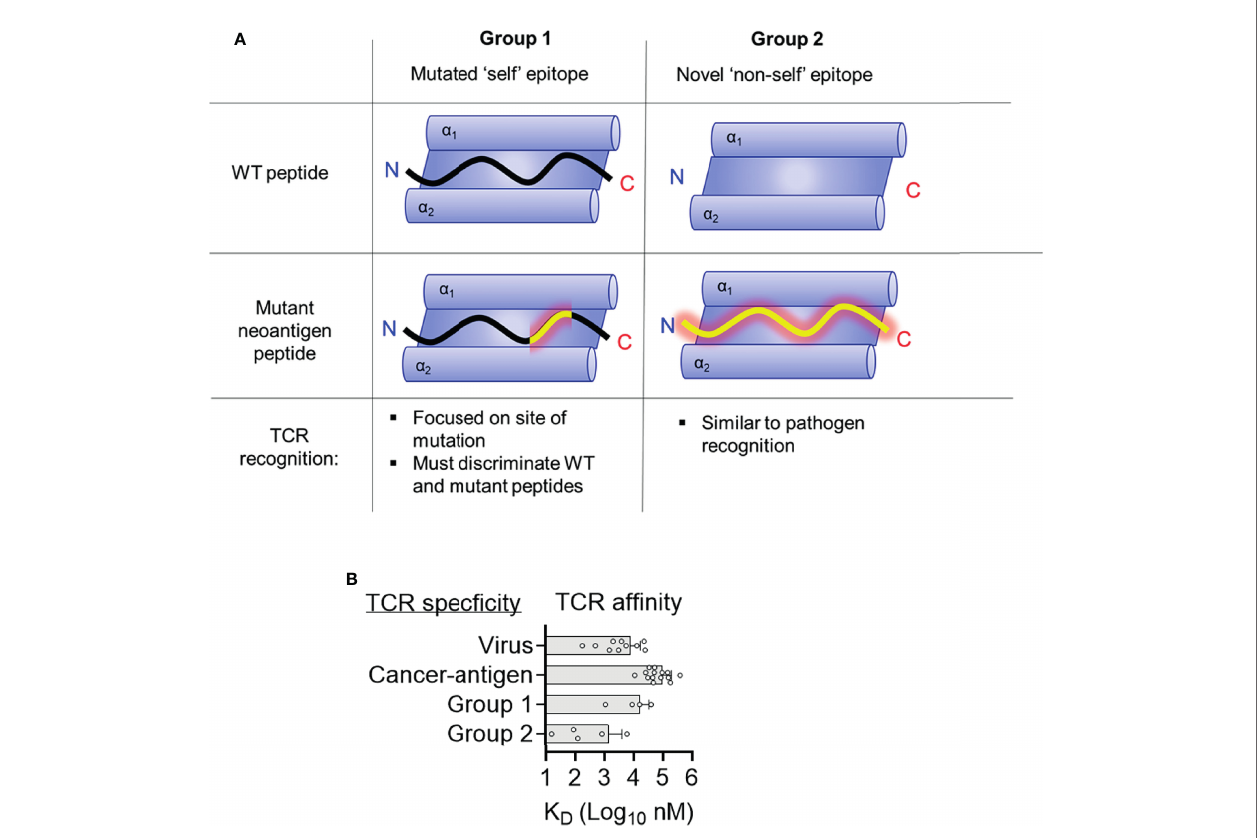
FIGURE 4 | Two distinct structural mechanisms for detection of neoantigens. (A) Distinct features of antigen presentation and TCR recognition of group 1 and group 2 neoantigens (B) Af fi nities of TCRs speci fi c for tumor antigens, viruses, and group 1 and group 2 neoantigens. Data for viruses and tumor antigens are from Aleksic et al.